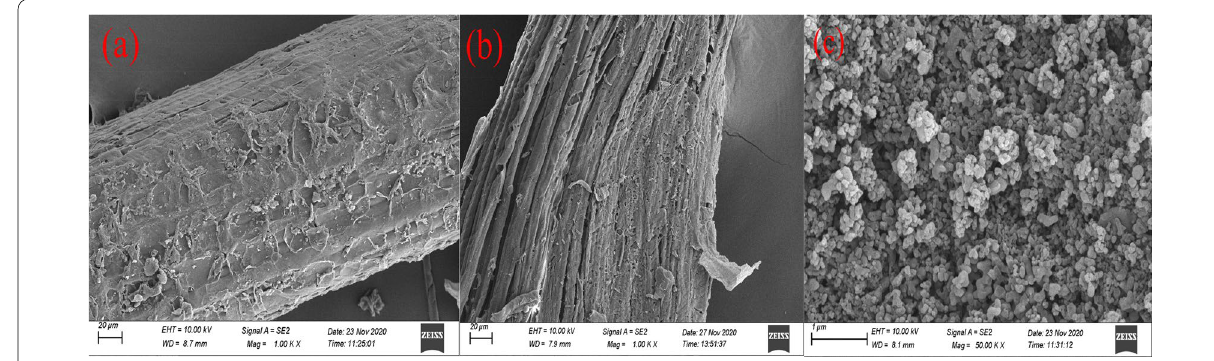
Fig. 10 SEM images of the original palm fiber ( a ), palm fiber treated with ethanol for lignin extraction ( b ), and the extracted lignin ( c )